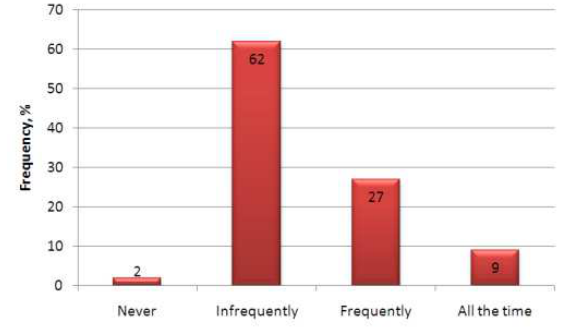
Fig. 9. Access to information on latest farming developments and innovations